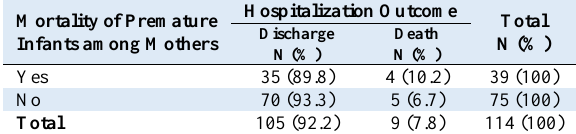
Table 3. The relationship between history of smoking fathers and premature infant mortality History of Smoking Fathers